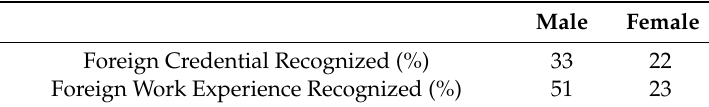
Table 3. Recognition of Foreign Credential and Work Experience among Immigrant Men and Women within Four Years after Landing in Canada (Houle and Yssaad 2010).